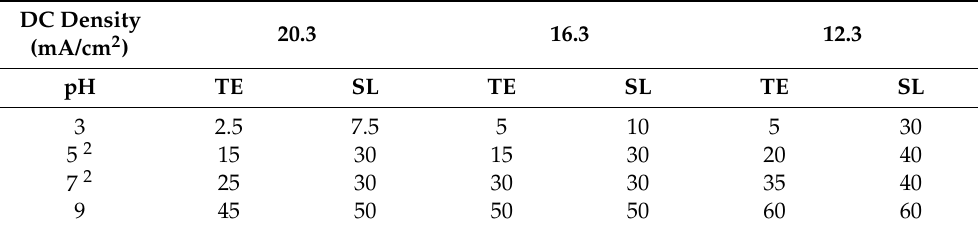
Table 3. Reaction times (min) to degrade naproxen transformation products when stainless-steel electrodes are used 1